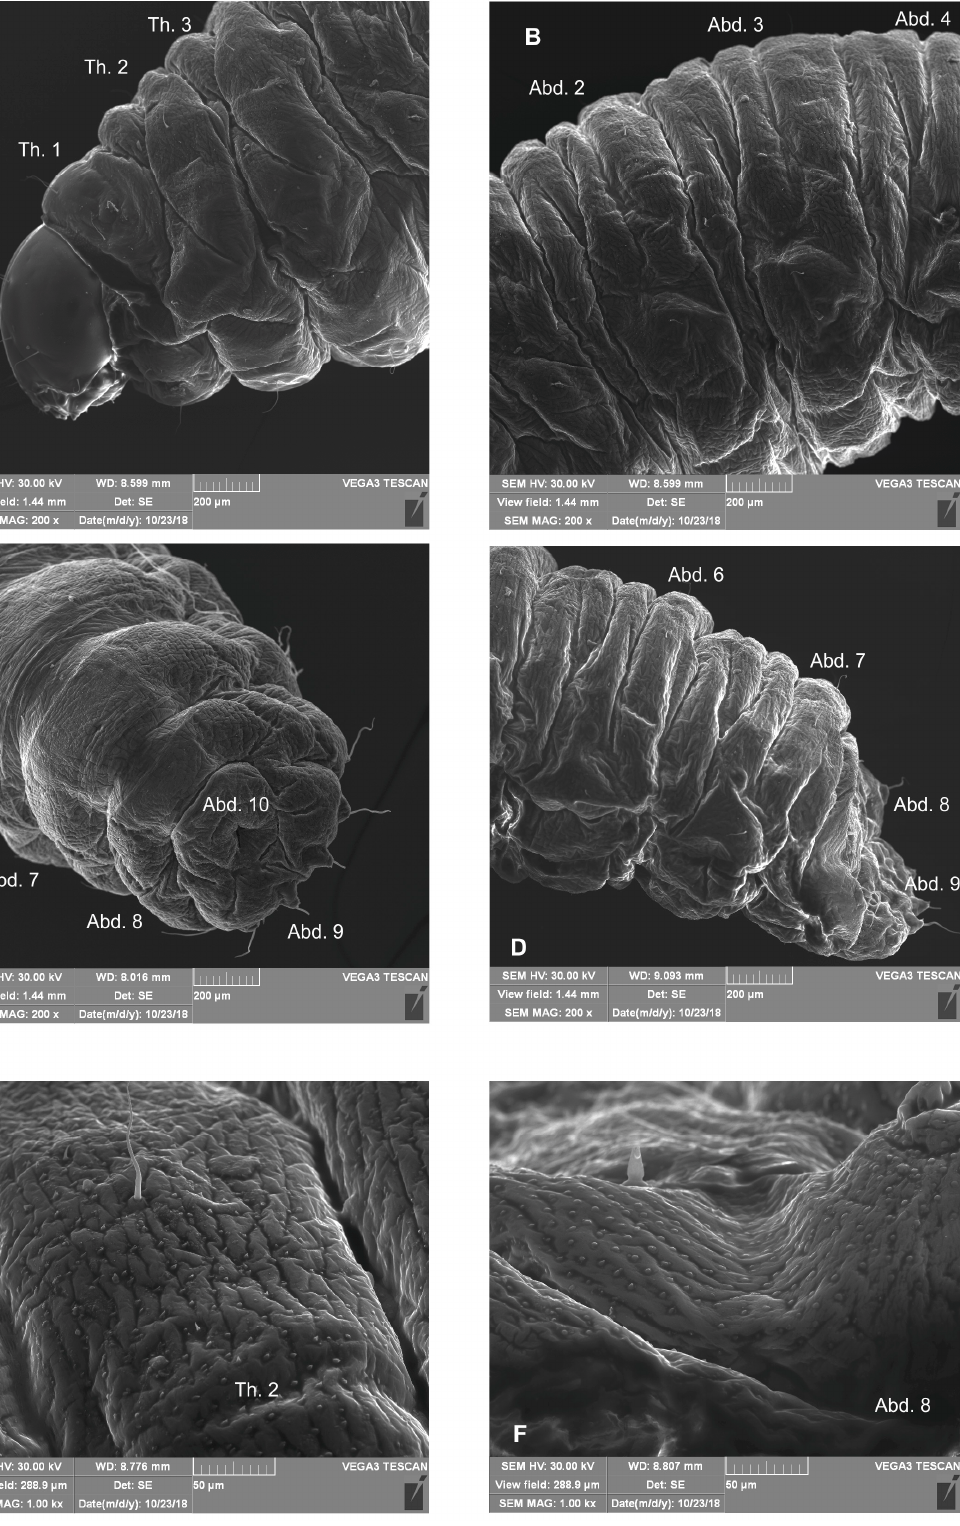
Figure 2. Bagous claudicans mature larva, habitus and cuticle, scanning electron microscope (SEM) photography. A —lateral view of thoracic segments; B —lateral view of abdominal segments; C —last abdominal segments, ventral view; D —last abdominal segments, lateral view; E —structure of cuticle on thoracic segment; F —structure of cuticle on abdominal segment 8 (Th. 1–3—thoracic segments 1–3, Abd. 1–10—abdominal segments 1–10).